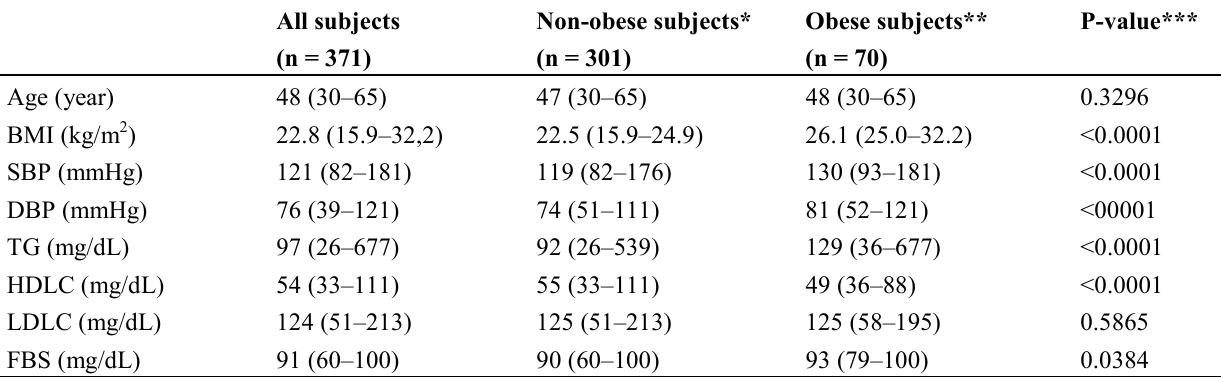
Table 1. Subjects’ profiles [median